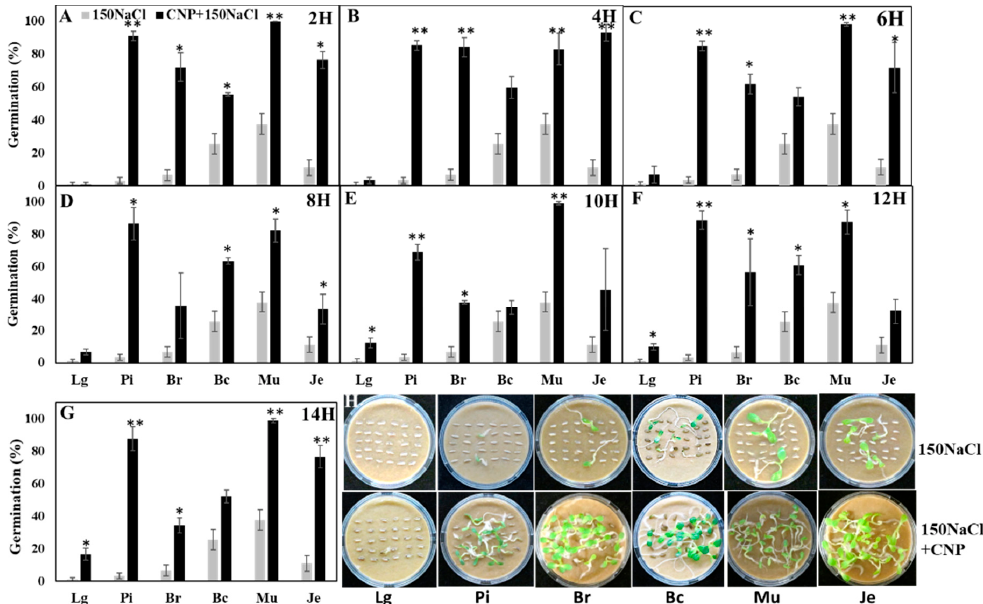
Figure 2. Germination of lettuce seeds pretreated without ( ■ ) or with carbon nanoparticles (CNPs) ( ■ ) in 150 mM NaCl solution. 2H in ( A ), 4H in ( B ), 6H in ( C ), 8H in ( D ), 10H in ( E ), 12H in ( F ), and 14H in ( G ) indicate CNP treatment period in hours. ( H ) Representative images for seed germination of different varieties pretreated with 150 mM NaCl or 150 mM NaCl +0.3% CNP for 4 h, followed by imbibition in the 150 mM NaCl solution for six days. Lg (Little Gem); Pi (Parris Island); Br (Breen); Bc (Butter Crunch); Mu (Muir); Je (Jericho). * and ** denote the statistical significance at the p < 0.05 and p < 0.01 level, respectively.